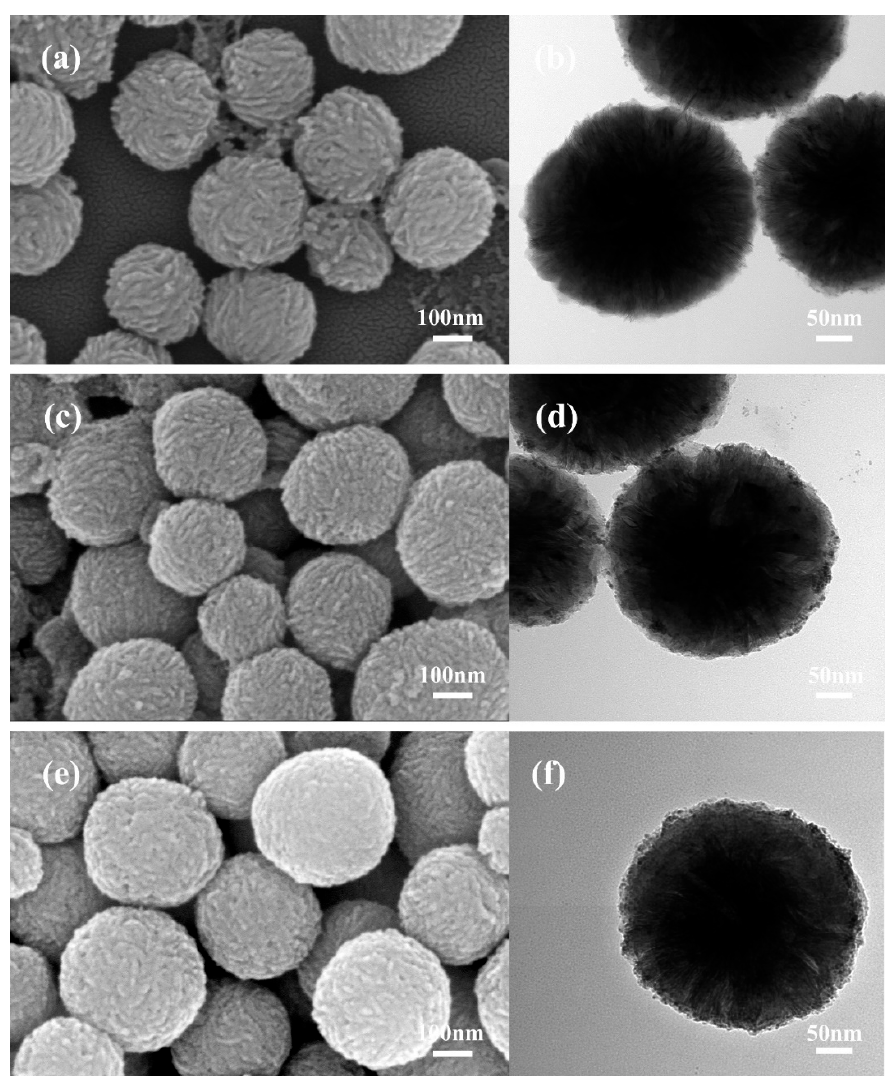
Figure 3. FESEM and TEM images of MoS 2 /PtCo-alloy NP composites (20 wt% PtCo-alloy NPs loading) prepared by different methods. ( a , b ) Co-reducing PtCo alloy directly; ( c , d ) adding PVP